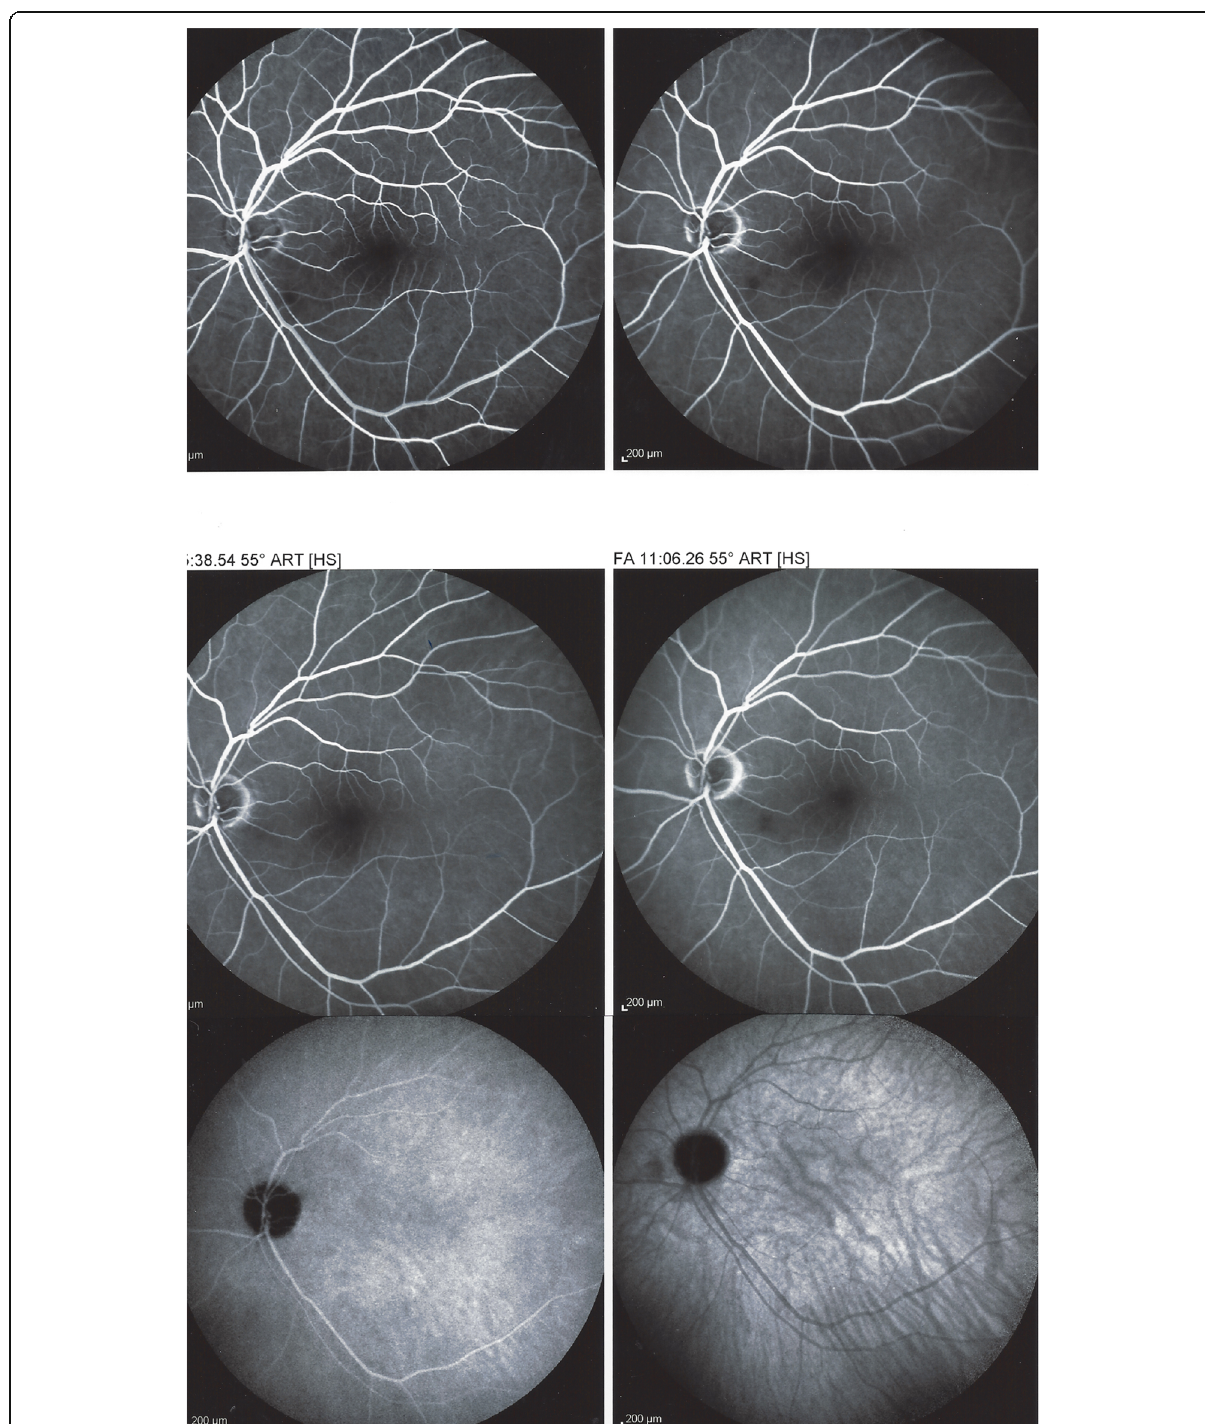
Fig. 13 Follow-up FA (top four frames) and ICGA bottom twoframes 5 weeks after acute episode and systemic corticosteroid treatment; complete resolution of arteritis (case